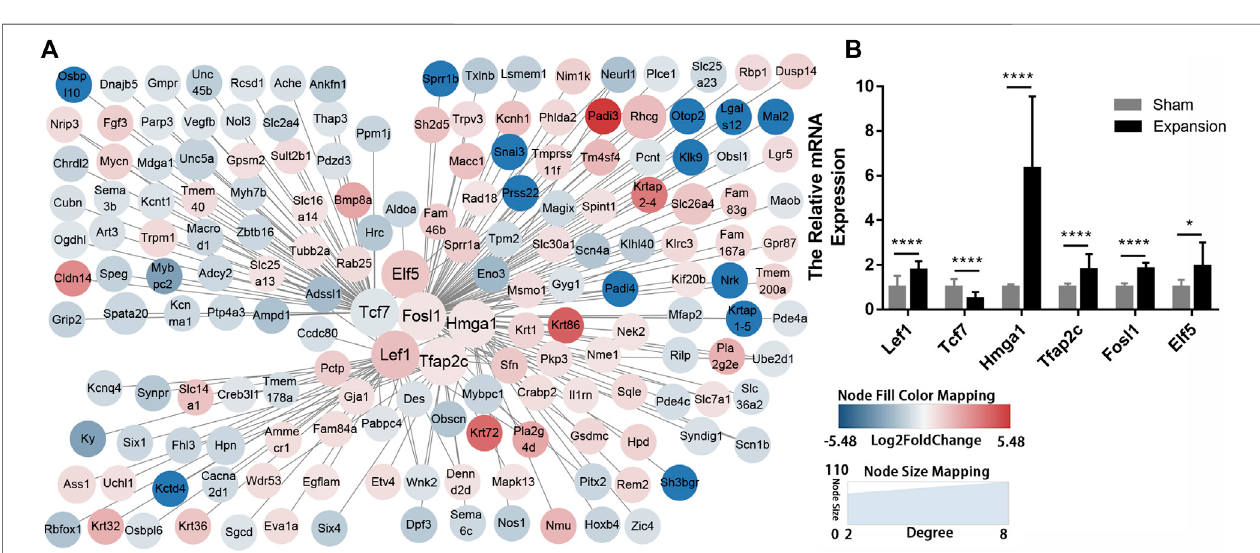
Frontiers in Genetics |